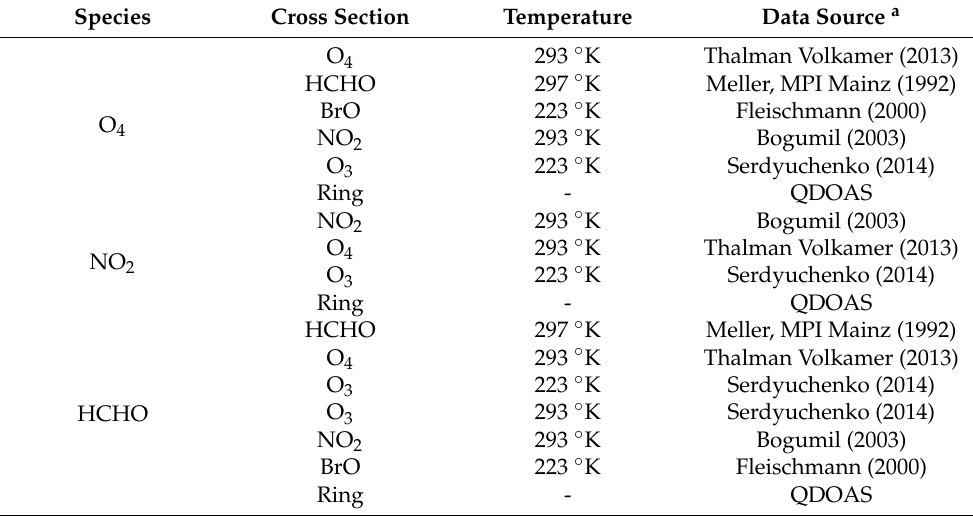
Table 1. The parameters of cross-sections and Ring effect in QDOAS.